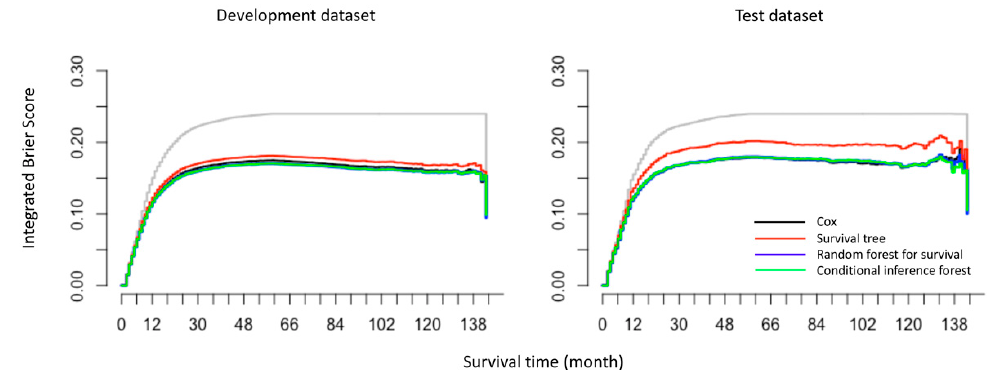
Figure 3. The prediction error curves for models (Cox regression, survival tree (ST), random forest for survival (RF) and conditional inference forest (CF)) in predicting disease-specific survival of oral and pharyngeal cancers based on the integrated Brier score (IBS). The maximum (observed) survival month was 143 for OPC patients in the SEER database. Different models are presented by different colors, where the grey curve represents a default benchmark Kaplan–Meier model. All curves start at time 0 where all subjects are alive and all predictions equal to 1.